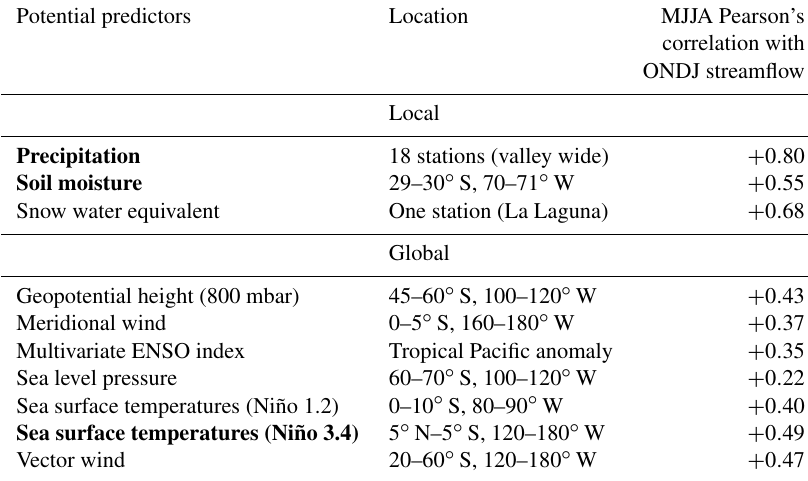
Table 1. List of potential predictors (bold predictors retained for statistical